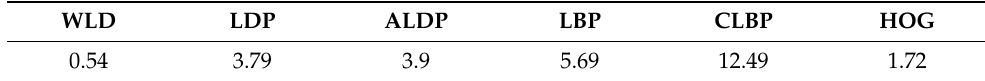
Table 5. Extraction times (in seconds).